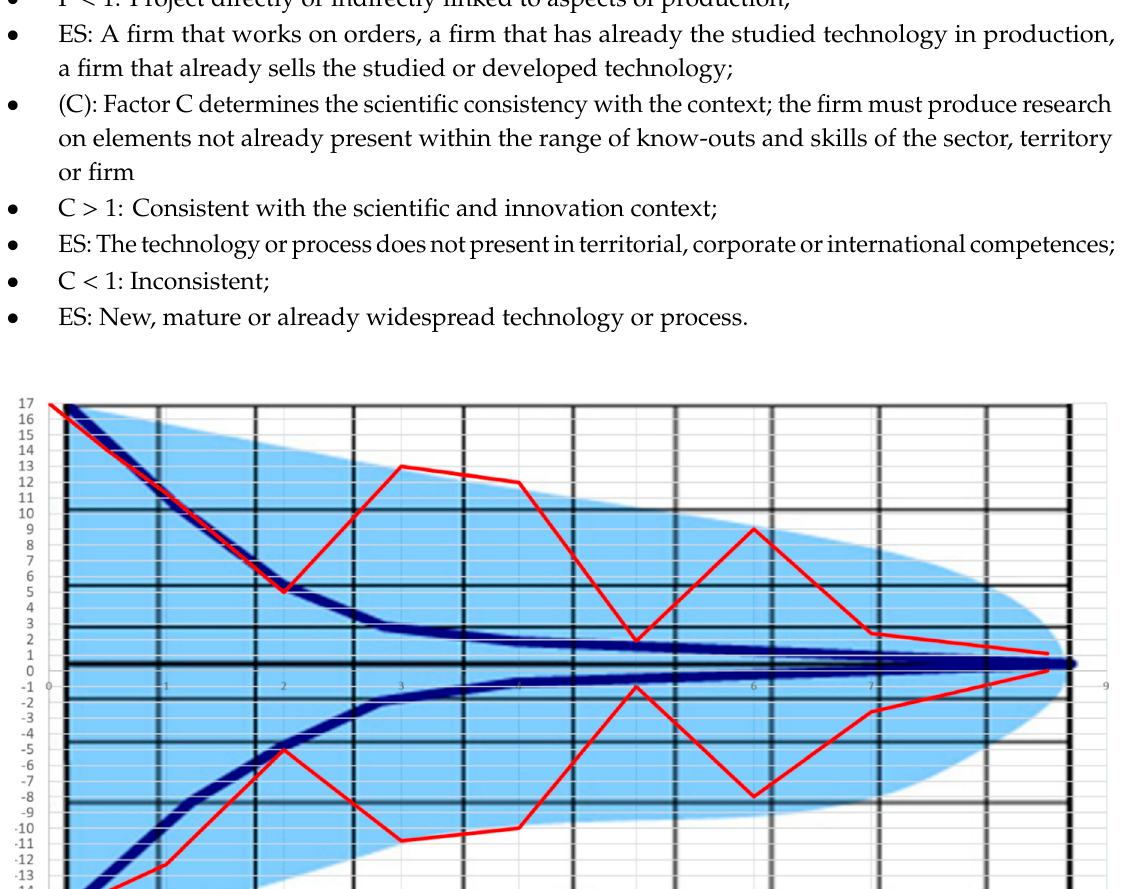
Figure 5. Uncertainty graph by trend line in red and in blue the trend line normalized.